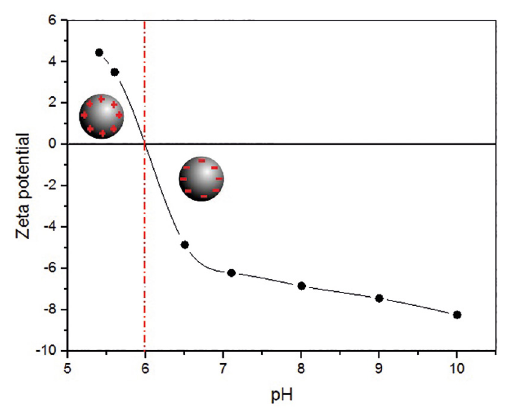
Figure 9. Thermograms of the magnetic